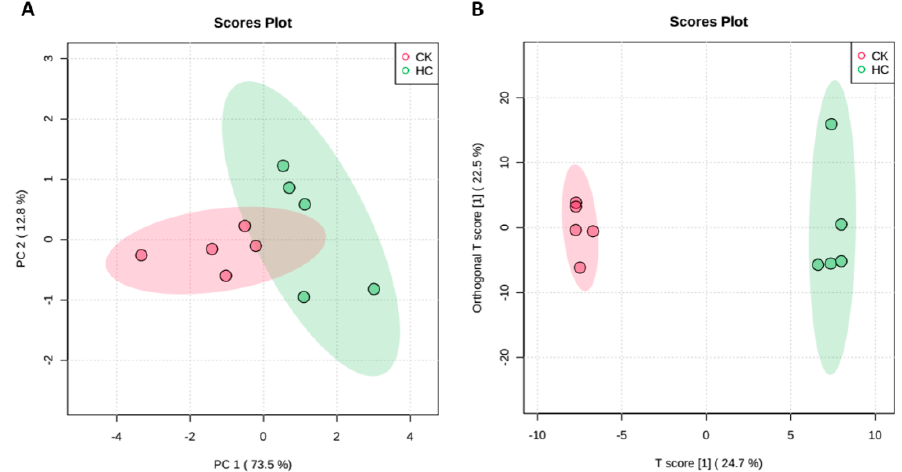
Figure 2. PCA ( A ) and OPLS—DA ( B ) score plots of metabolic profiles in the HC treatment (HC) and the control (CK).